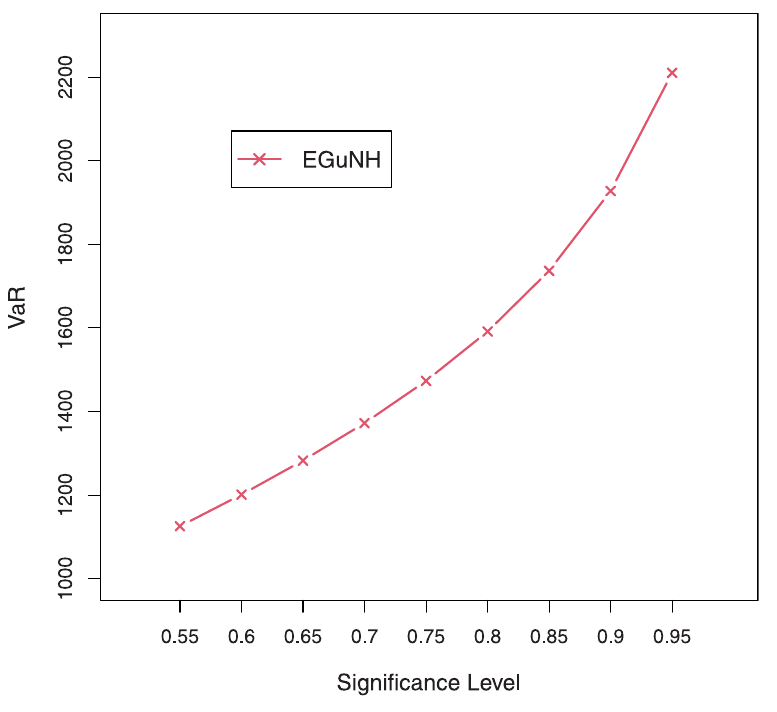
Fig 39. Estimated ES for D2.